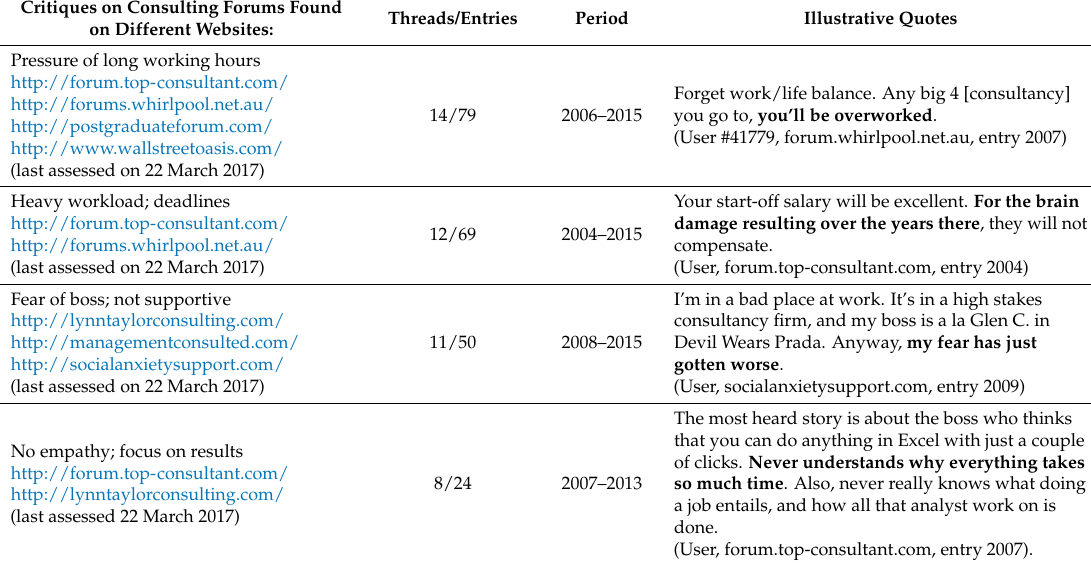
Table 1. Moral taint indications of over-demanding managers on Internet forums.